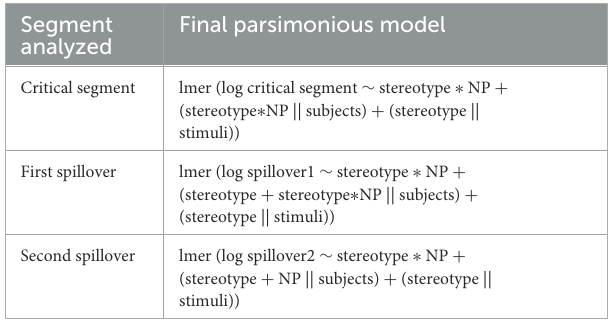
TABLE 2 Resulting parsimonious models for reading times on the three analyzed segments of Experiment